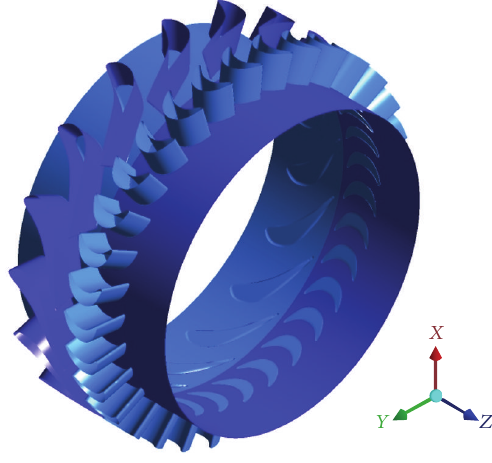
Figure 1: Three-dimensional geometry of the expansion turbine.